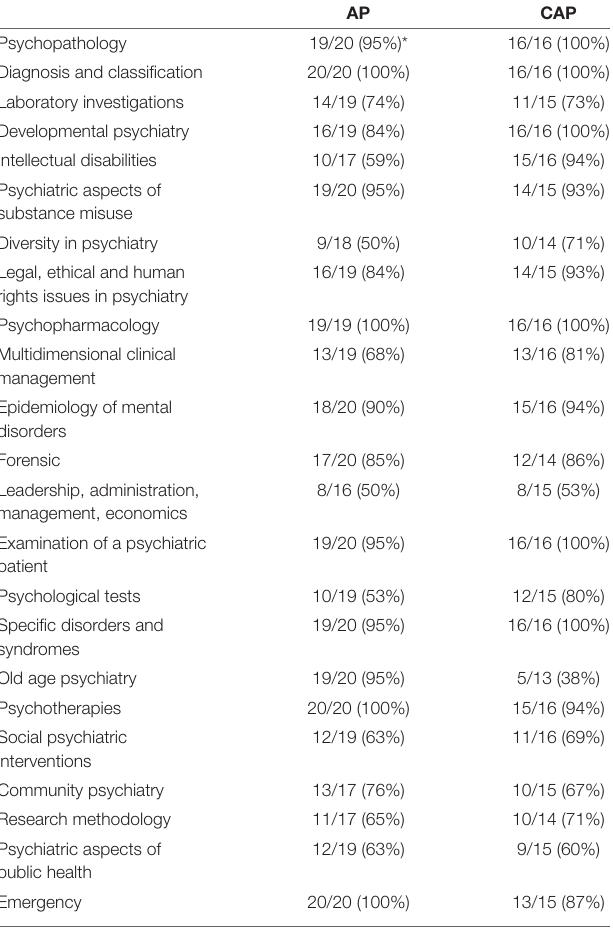
TABLE 3 | Mandatory content of theoretical training in each speciality (according to UEMS